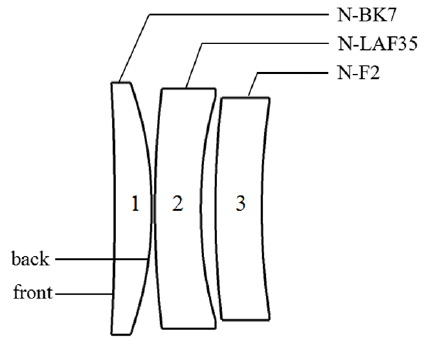
Figure 7. The configuration of the corrector group.